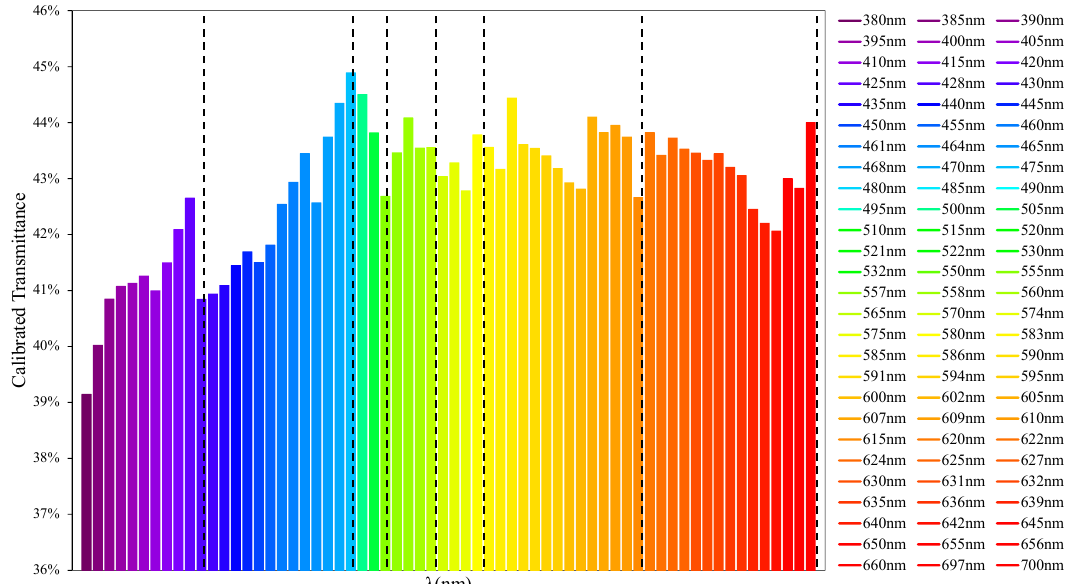
Figure 17. Transmittance values calculated at the tipping point of the calibration lines of Figure 16. Transmittance LED 50%.